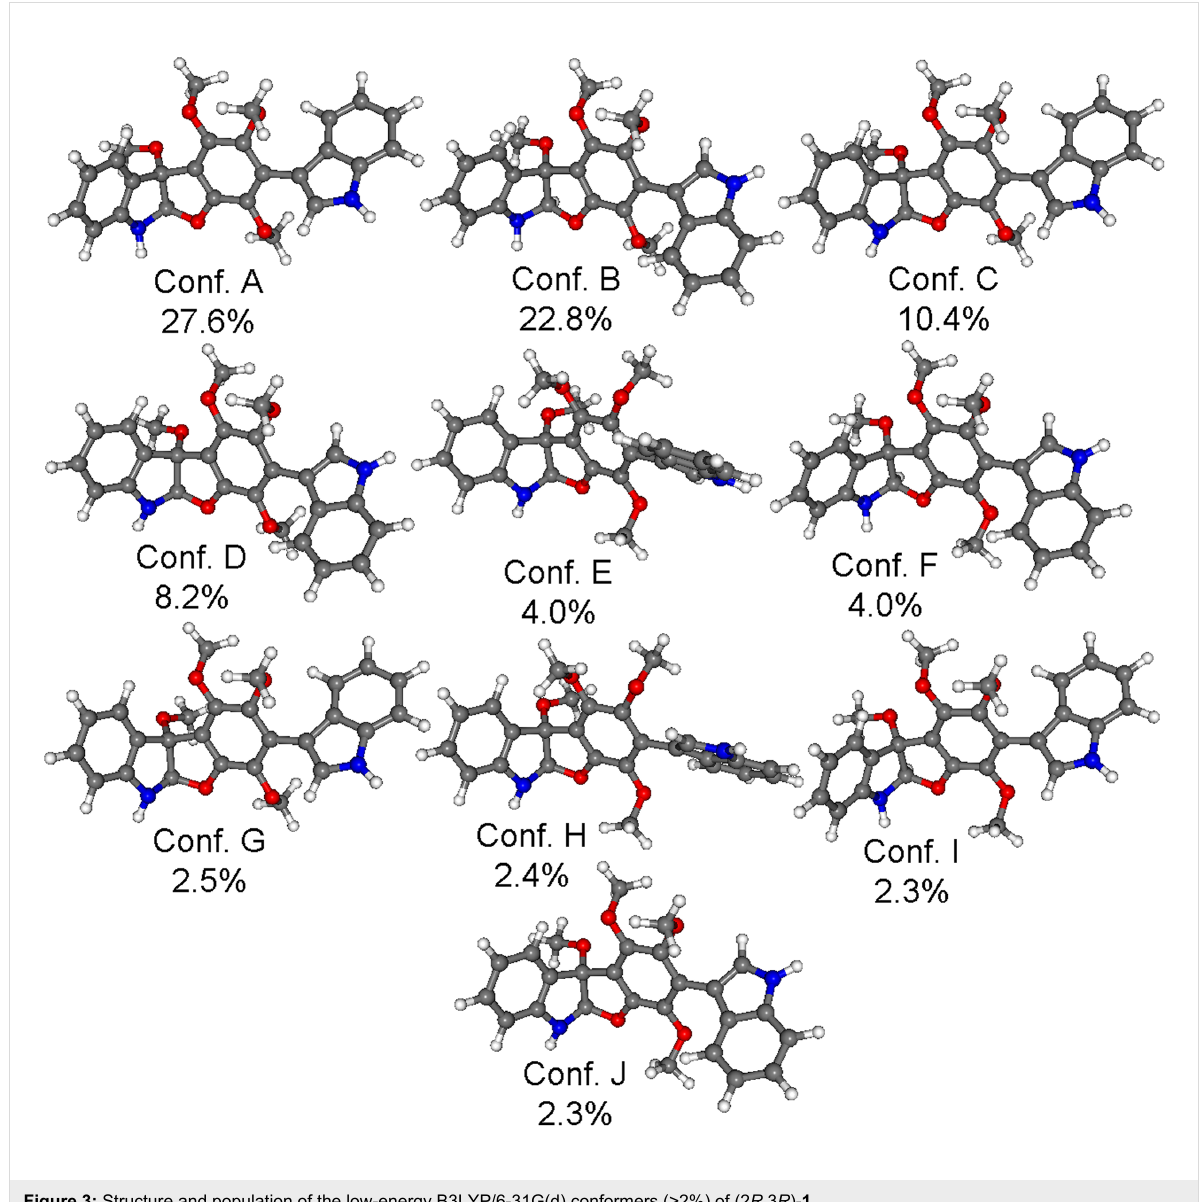
Figure 3: Structure and population of the low-energy B3LYP/6-31G(d) conformers (>2%) of (2 R ,3 R )- 1 .